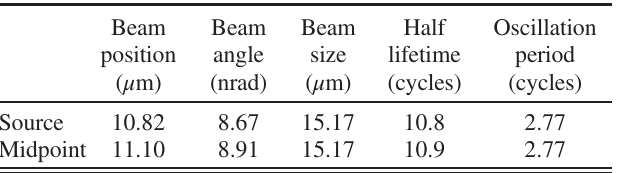
TABLE III. Comparison of the beam characteristics at the source location and at the midpoint of the return path for the cavity with the systematically misaligned crystal yaw angles ( δ ¼ 0 . 10 μ